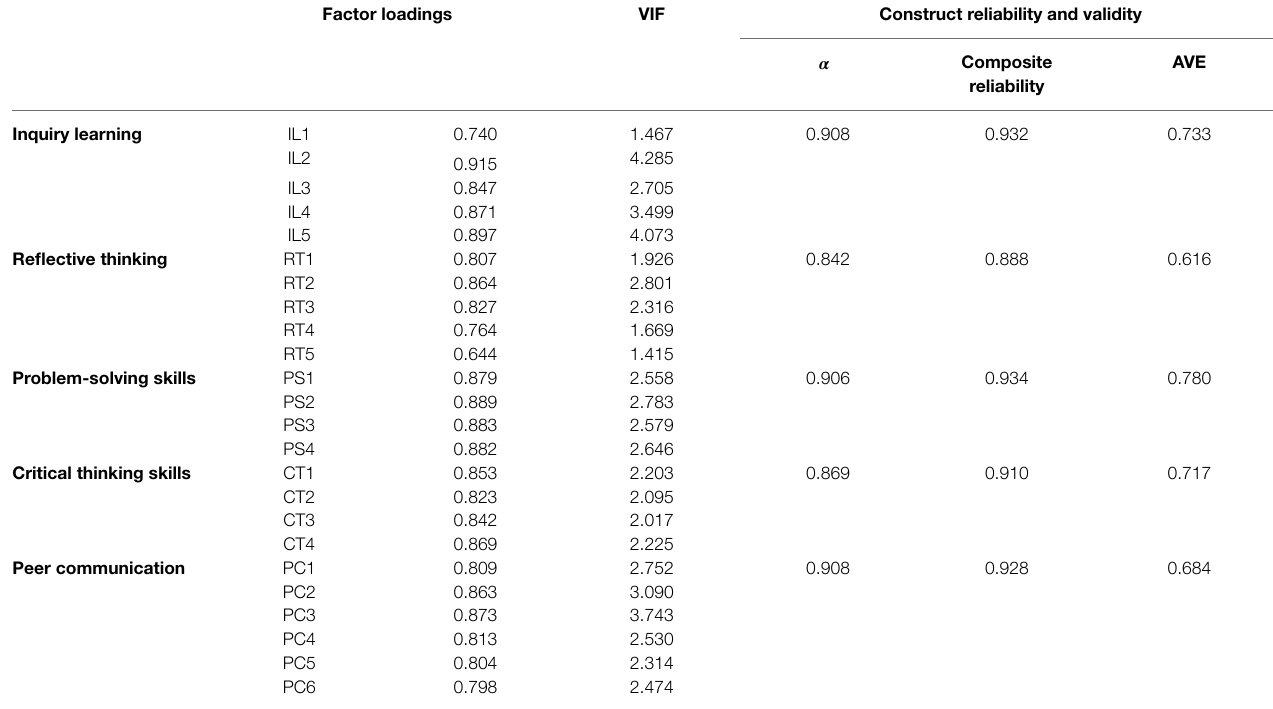
TABLE 2 | Model assessment (direct model).